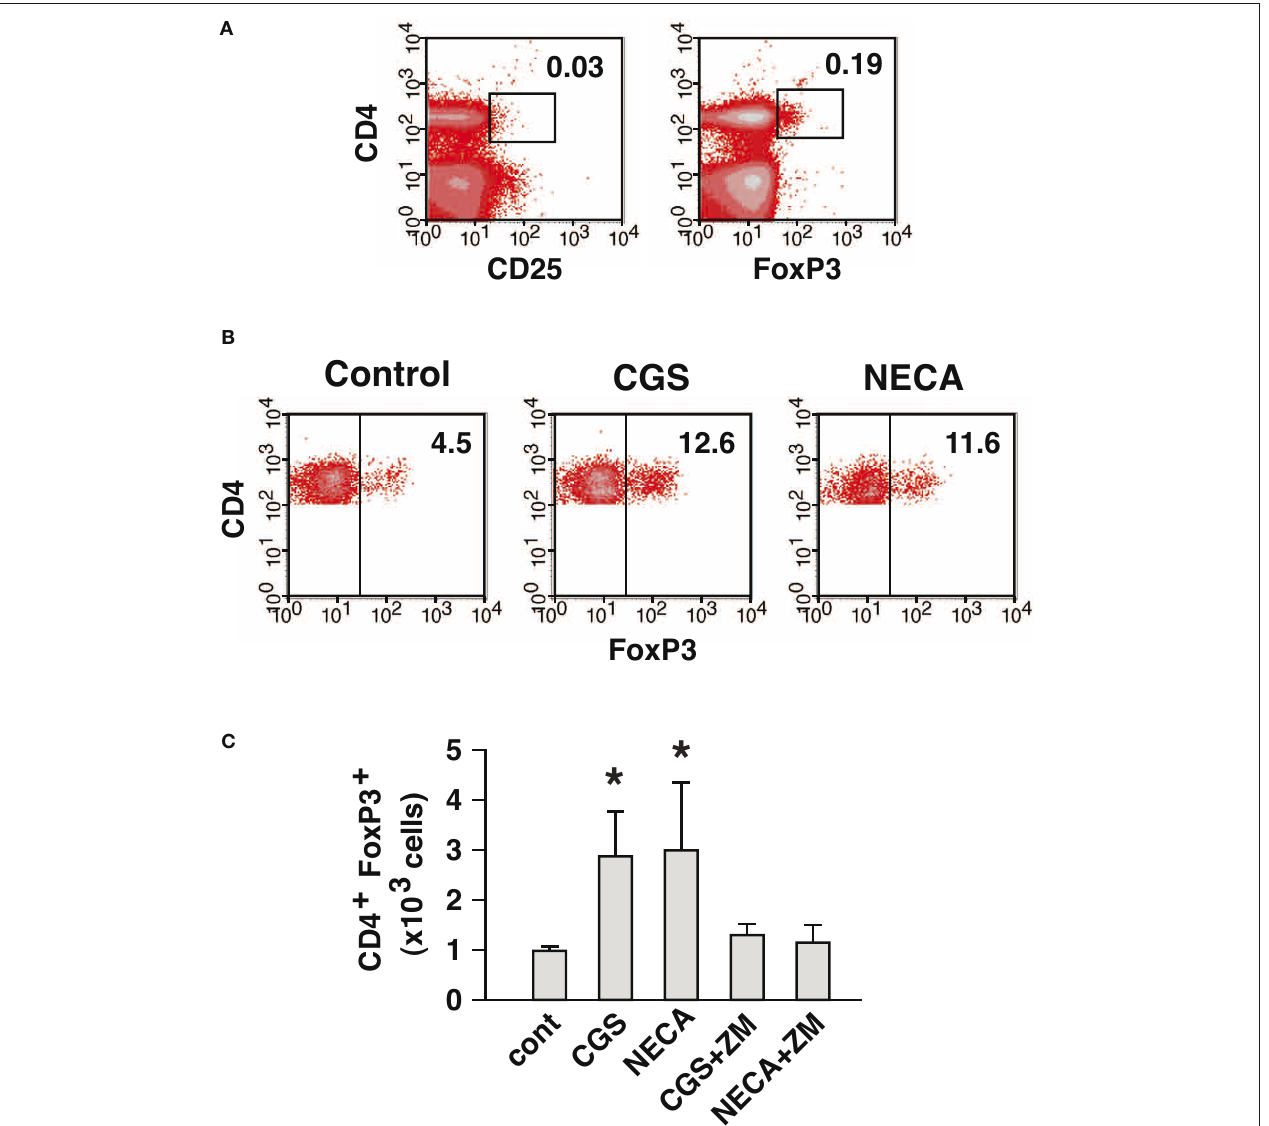
in the presence of A2AR agonists. The data were gated for CD4 + cells. The numbers represent percentages of FoxP3 + cells in CD4 + population. The data shown here represent three separate experiments with similar results. (C) Numerical increase of CD4 + FoxP3 + cells derived from CD4 + CD25 − cells. Total live cells were enumerated after 7 days, and numbers of H-2K b + CD4 + FoxP3 + cells were calculated as in Figure 6 . Data represent average ± SD of three separate experiments. ∗ P < 0 . 05 vs.